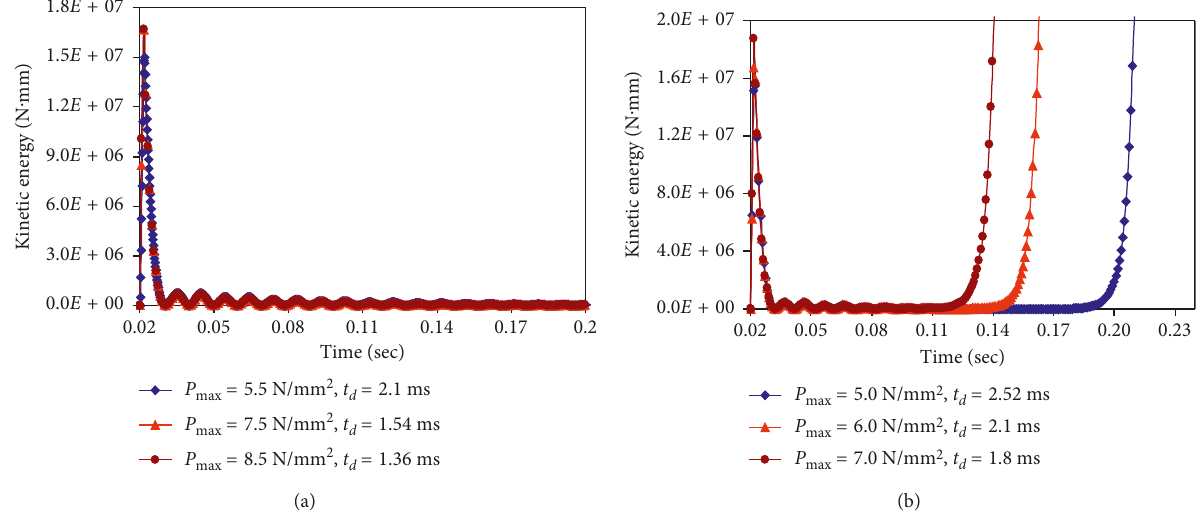
Figure 10: Comparison of the kinetic energy time histories of steel column W150 50% of the design axial load: (a) without column failure; (b) with column failure.